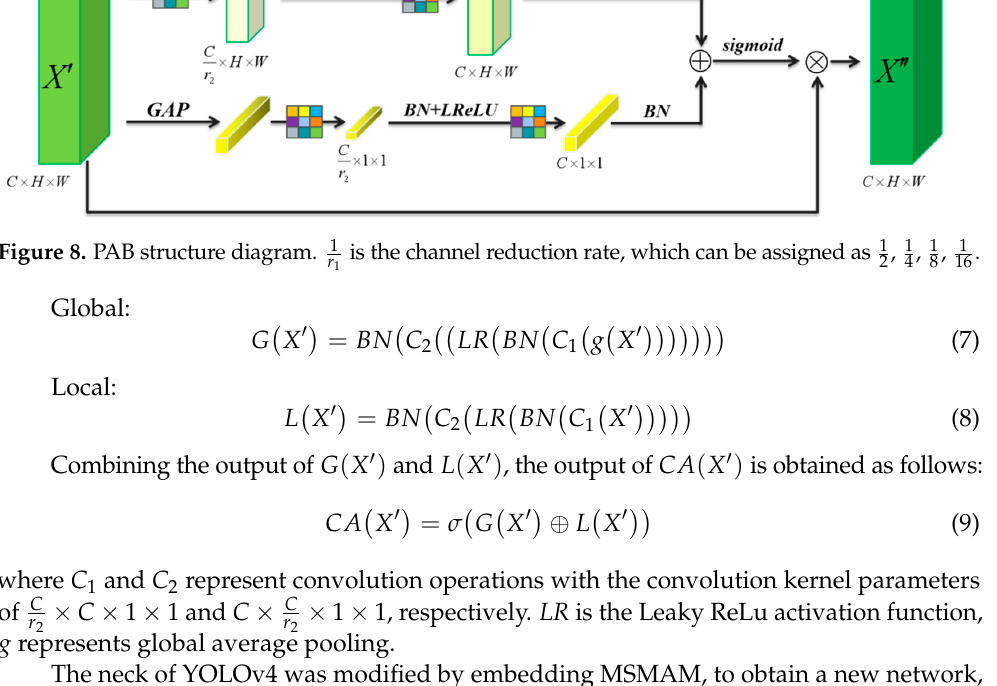
Figure 8. PAB structure diagram. (cid:2869)